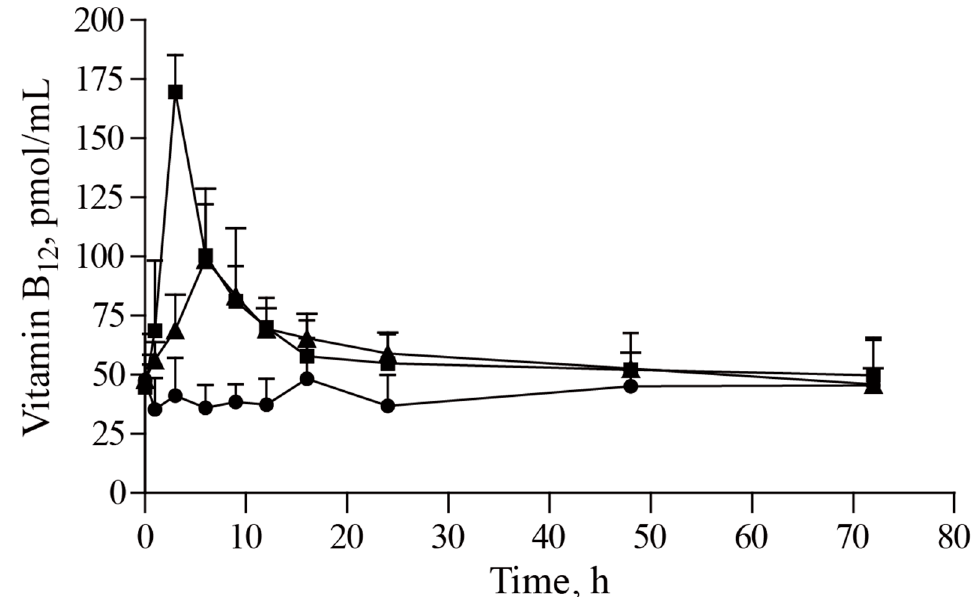
Figure 10. The plasma concentration of vitamin B 12 versus time. The concentration of vitamin B 12 in plasma from 0 to 72 h after oral placebo ( ● ), non-microencapsulated vitamin supplement ( ▪ ), and microencapsulated vitamin supplement ( ▲ ), respectively. Error bars represent standard devia- tions. Table 3. Pharmacokinetic parameters of plasma water-soluble vitamin concentrations in pigs 1